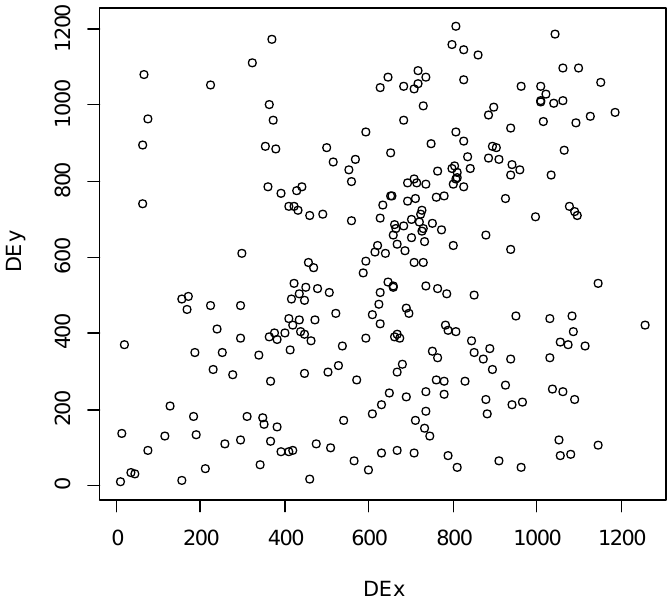
Figure 2. TTF recorded for pairs of Components D and E